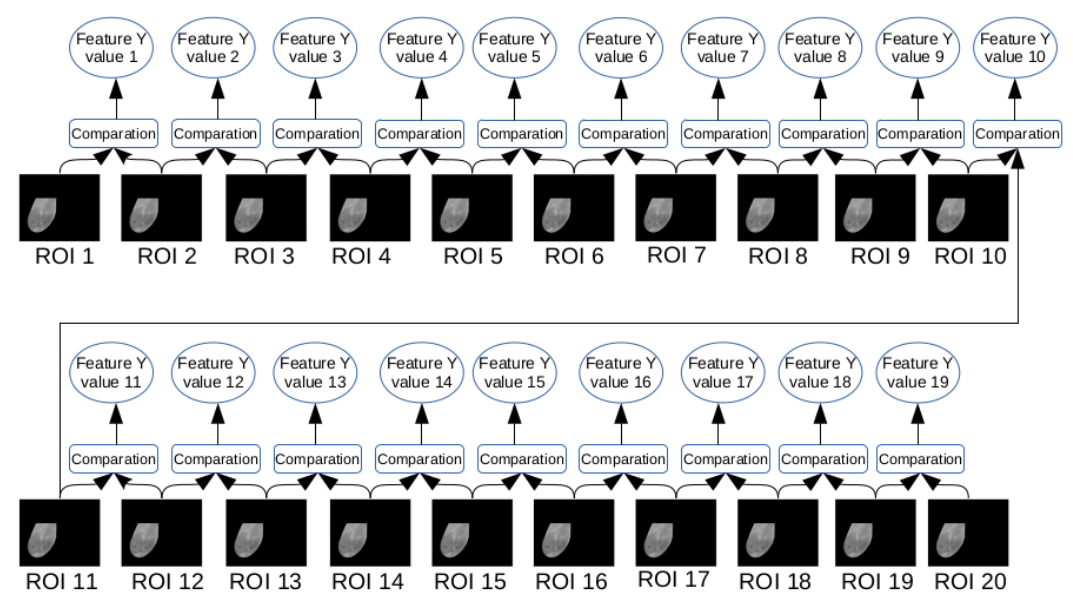
Figure 8. Representation of features based on comparison of consecutive